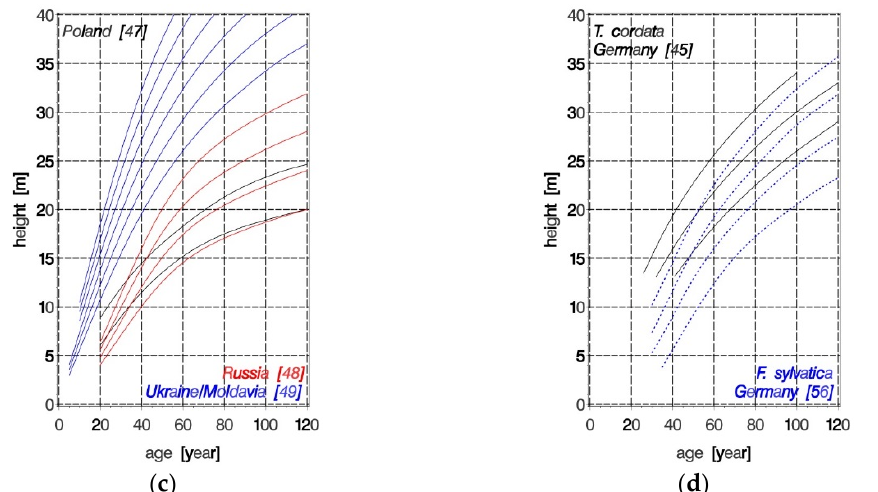
Figure 1. ( a ) Comparison of height growth of T. cordata originating from generative (black, solid) vs. vegetative (blue, dotted) regeneration (Hungary [46]); ( b ) T. cordata from Lithuania [55]; ( c ) T. cordata from Poland (black, solid) [47]; Ukraine/Moldavia (blue, solid) [49]; and Russia (red, solid, values not displayed: 140–200 years) [48]; ( d ) T. cordata (black, solid) [45] vs. F. sylvatica (blue, dotted) [56], both Germany.